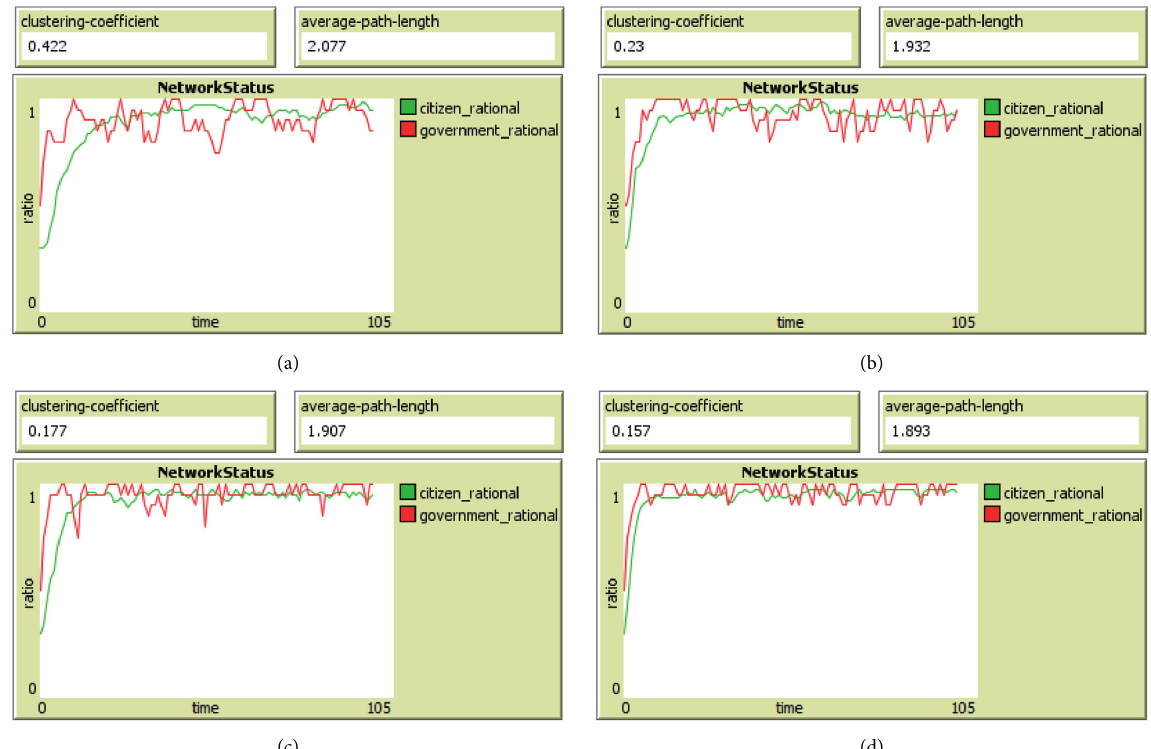
Figure 8: The evolutionary result when the reconnection probability p takes different values in scenario four: (a) the evolutionary result when p � 0.2; (b) the evolutionary result when p � 0.4; (c) the evolutionary result when p � 0.6; (d) the evolutionary result when p �